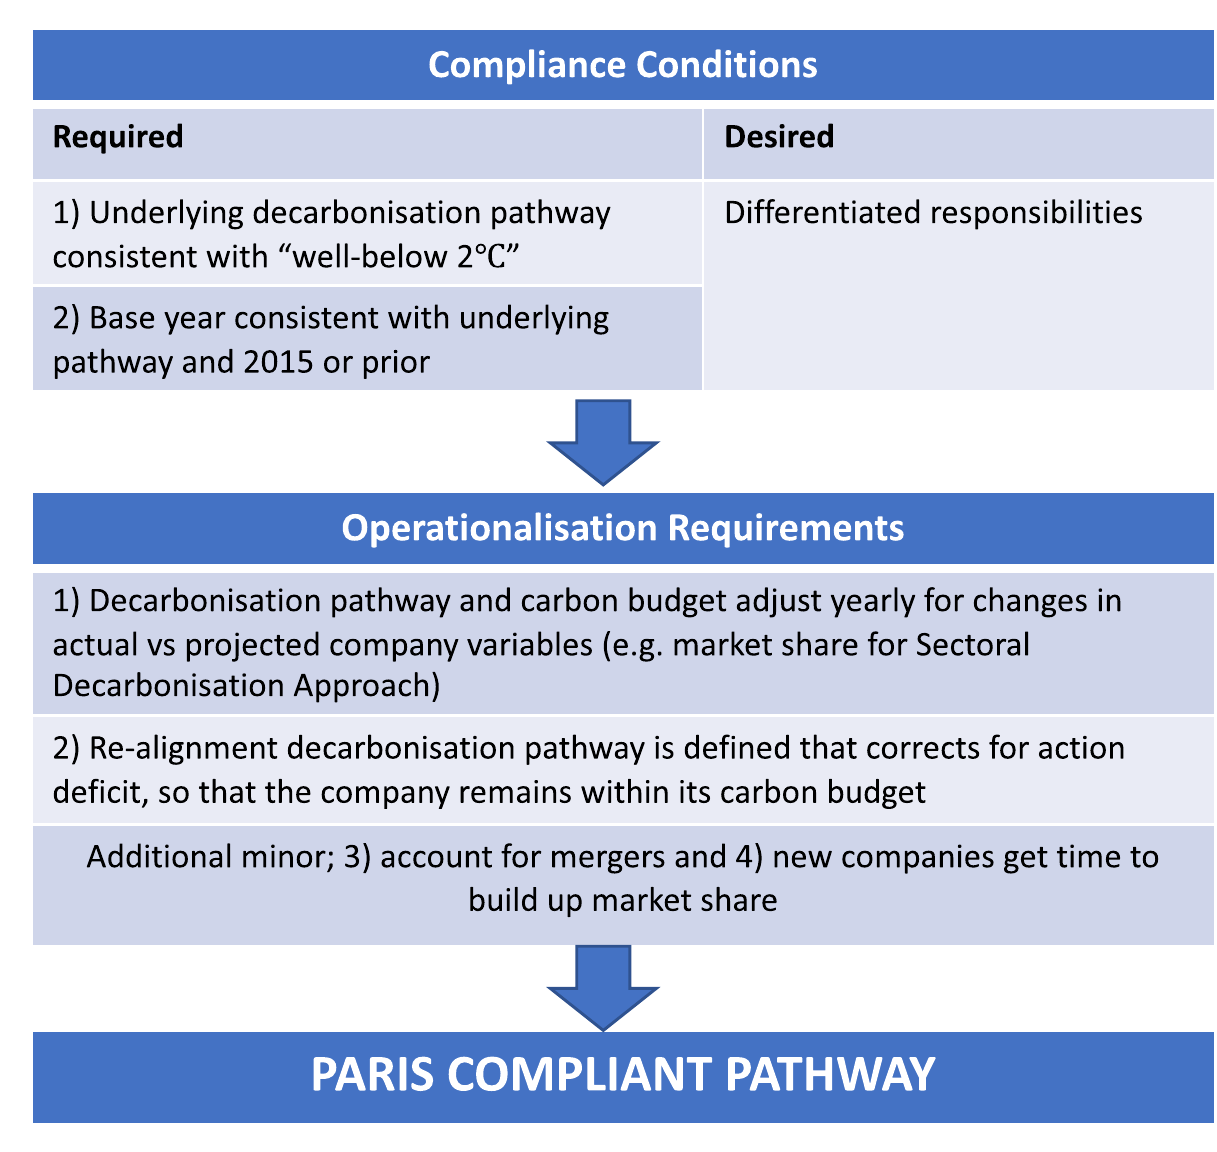
Fig. 1 The Paris Compliant company: condition and operationalisation requirements. This fi gure summarises the conditions and operationalisation requirements we propose for a companies' decarbonisation pathway to be Paris Compliant, i.e. a Paris Compliant Pathway